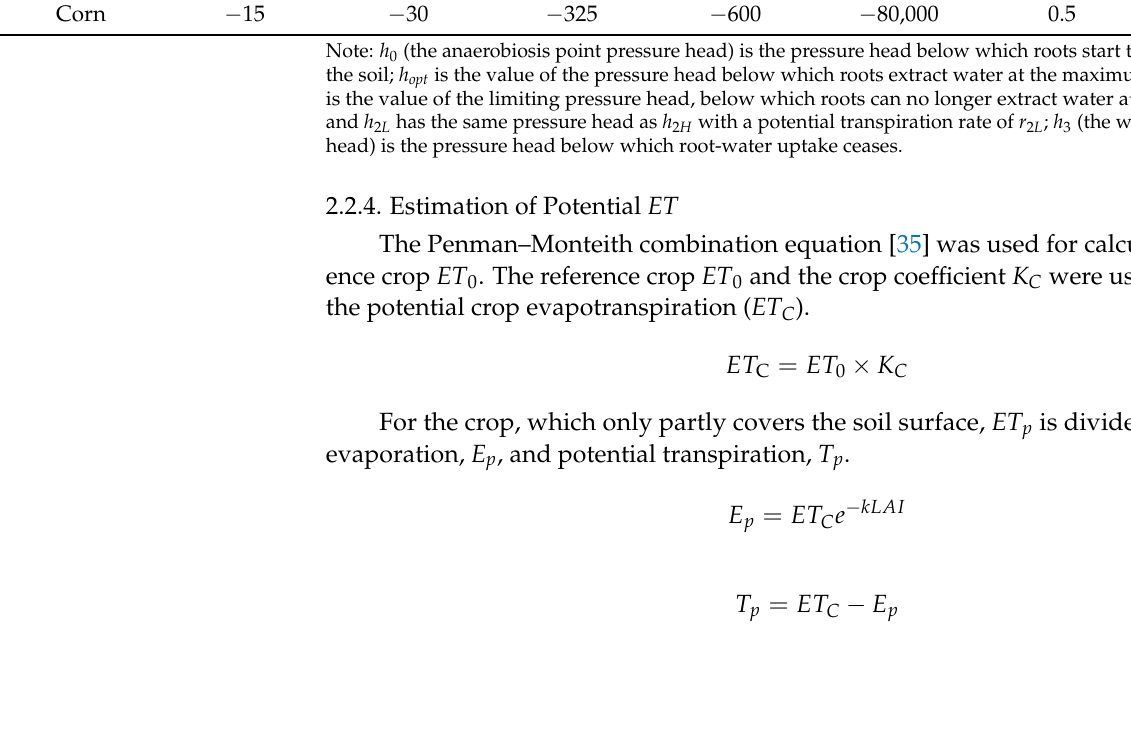
Table 2. Water stress response function parameters used in Hydrus-1D. Root Water Uptake Crop